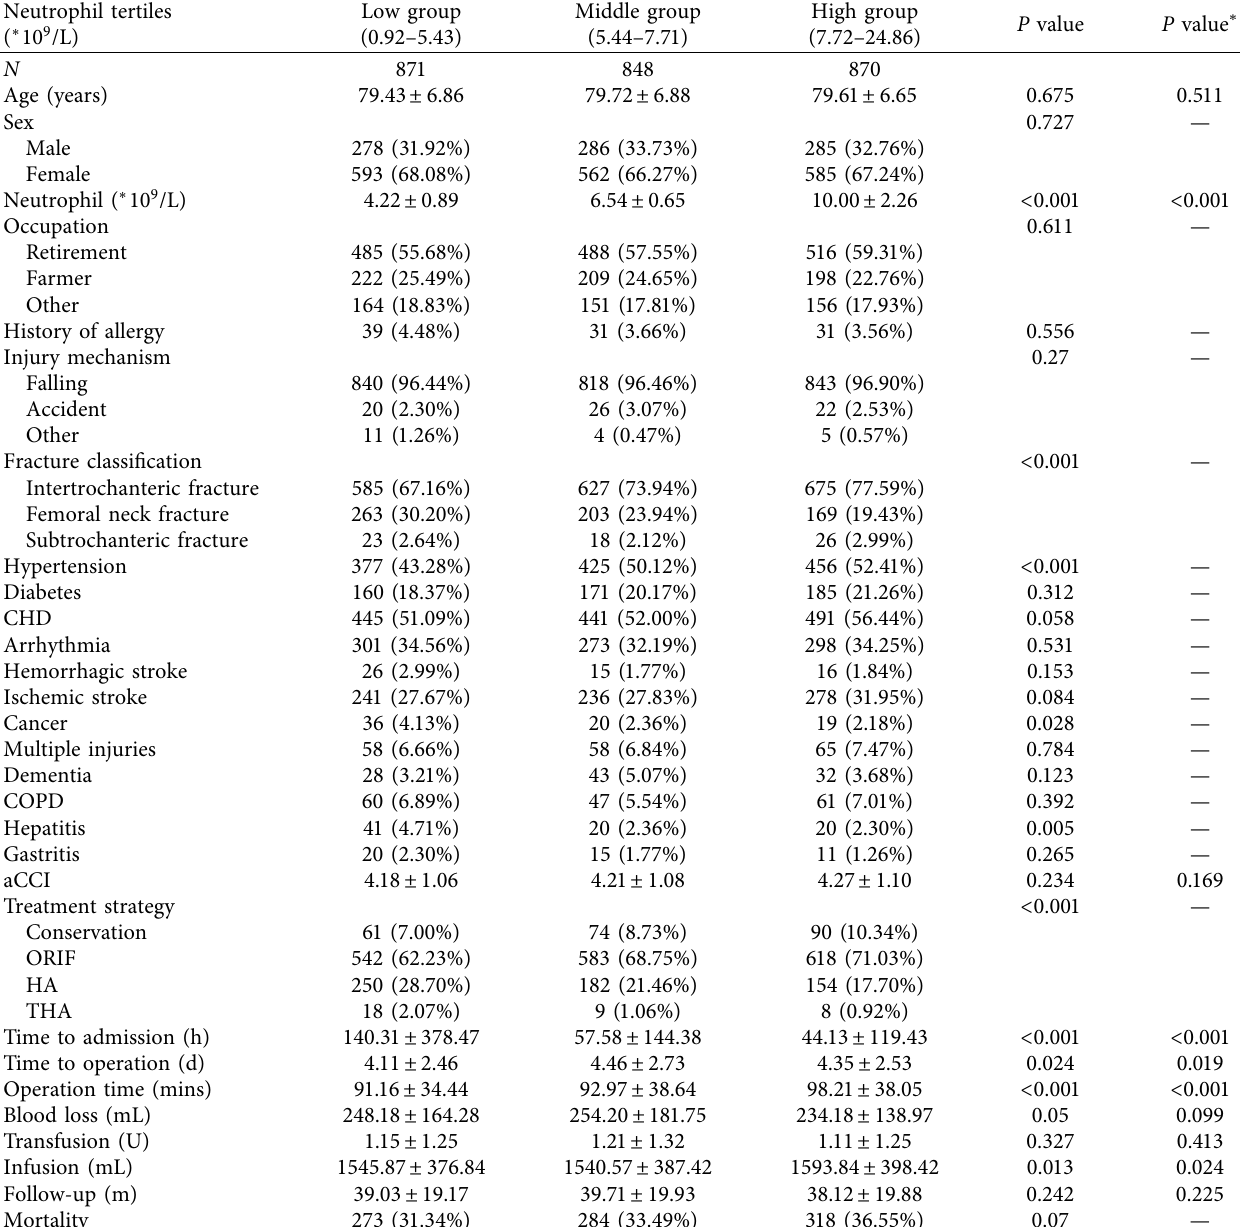
Table 1: Te demographic and clinical characteristics ( N �